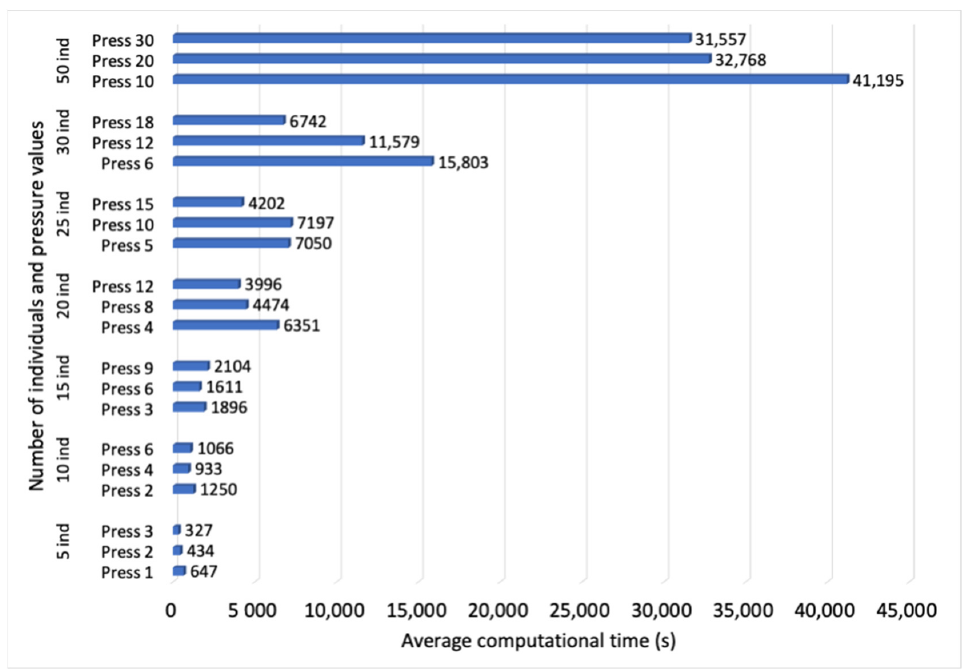
Figure 4. Average computational time (s) for populations built of different number P of individuals and pressure values.